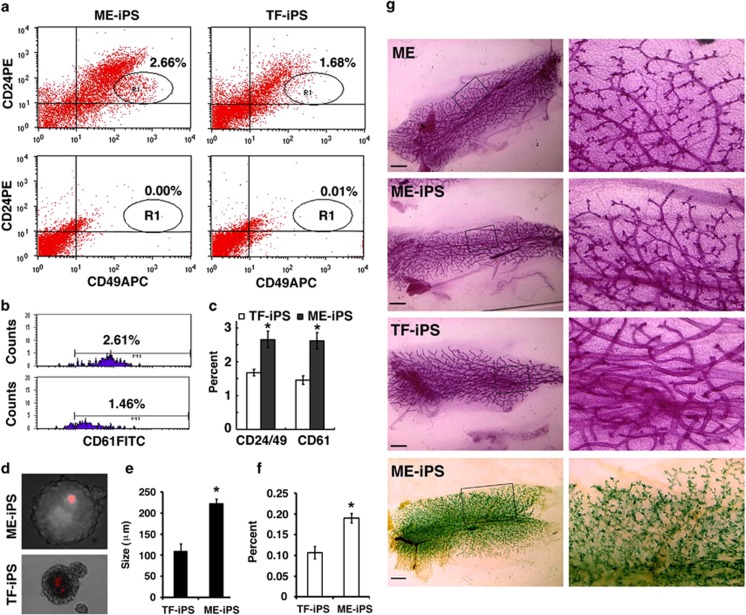
Analysis of mammary precursor cells and mammary gland formation. (a–c) FACS analysis using CD24-PE, CD49-APC, and CD61-FITC together. The percentages of CD24MedCD49High cells in region 1 (R1) (a and c) and CD24MedCD49HighCD61+ cells (b) are shown. Isotype controls for CD24MedCD49High cells are shown in the lower part of panel a. *P<0.05. The profiles from one pair of iPSCs are shown in panels a and b, and the percentages are from the average of five pairs of iPSCs that differed significantly, as indicated in panel c. (d–f) Morphology (d), size (e), and percentage (f) of mammospheres of iPSCs in vitro. *P<0.05. (g) Morphological features of the mammary glands produced in fat pads of nude mice. The boxed areas are enlarged (right). The gland stained by X-gal was formed by the injection of D-ME-iPSCs (derived from Rasa-26 mice). The formation of mammary glands by the injection of D-TF-iPSCs cells was also confirmed using X-gal staining (data not shown). The cleared portion of each mammary fat pad, which contains a lymph node, was stained for whole-mount imaging to confirm that the surgery was successful. The recipient mice were killed 6–8 weeks after implantation, and no tumors were observed in any recipient (n>60). Bars, 1 mm. More than five pairs of independently derived ME-iPSCs and TF-iPSCs were analyzed and similar results were obtained